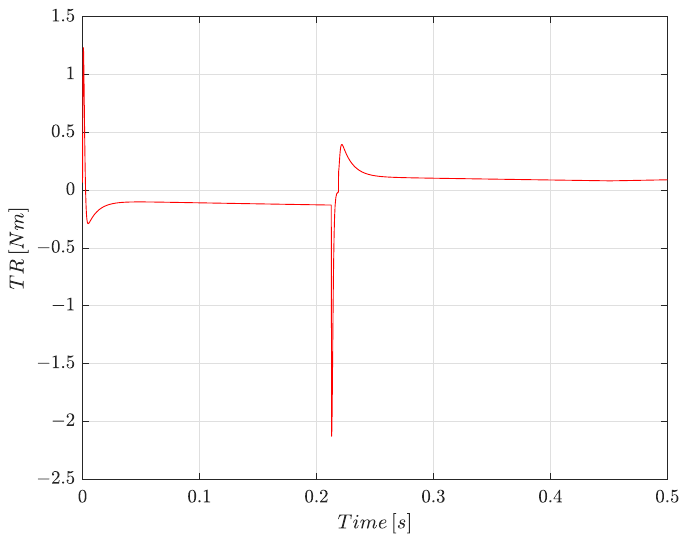
Figure 7. Residual torque trend over time during a simulation. The sudden spike at about 0.21 s is due to the fact that the motor starts rotating in the opposite direction at that point.